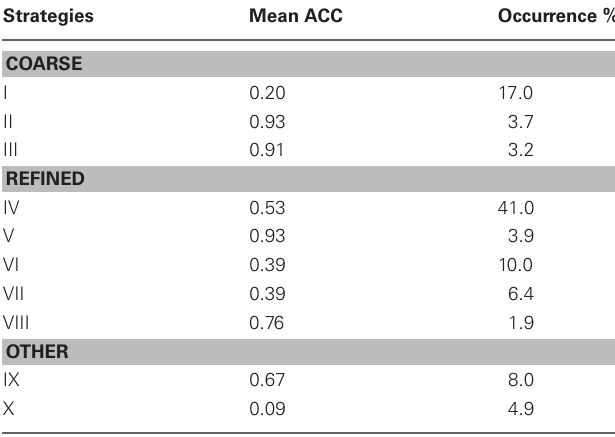
Table 1 | Mean and standard error of accuracy and frequency of occurrence for different